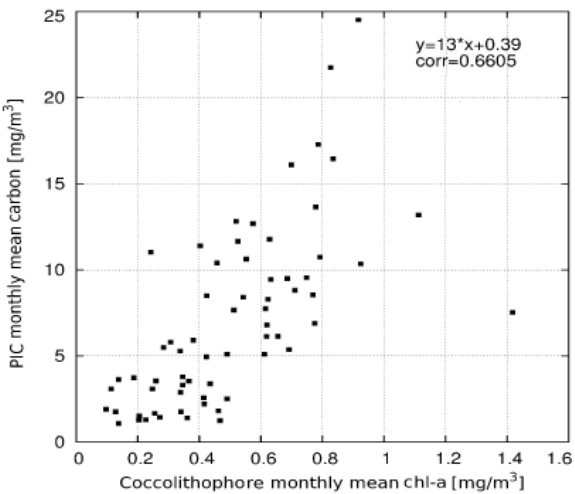
Fig. 9. PhytoDOAS coccolithophore chl a [mgm − 3 ] versus MODIS PIC [mgCm − 3 ] for a region in the North Atlantic, con- fined to these geographical boundaries: 14 ◦ W–24 ◦ W and 53 ◦ N– 63 ◦ N. Each data point corresponds to the respective monthly mean value from January 2003 to December 2010, according to Sadeghi et al.